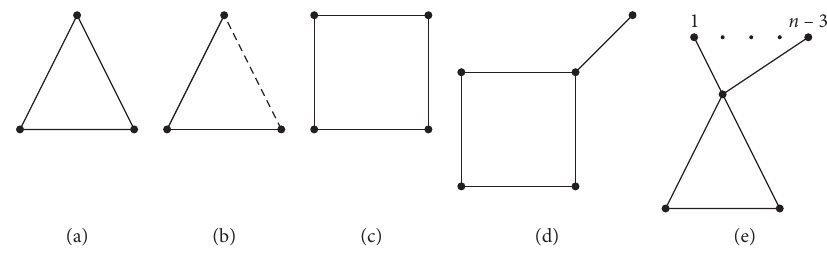
Figure 5: Unicyclic signed graphs with minimal energy. (a) C +